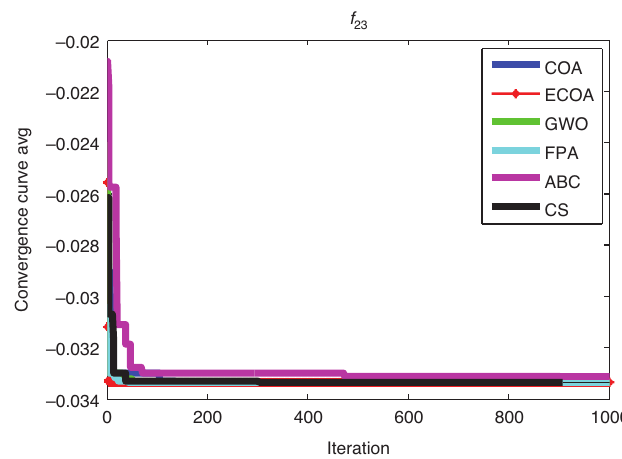
Figure 45: D = 2, Evolution Curves of Fitness Value for f